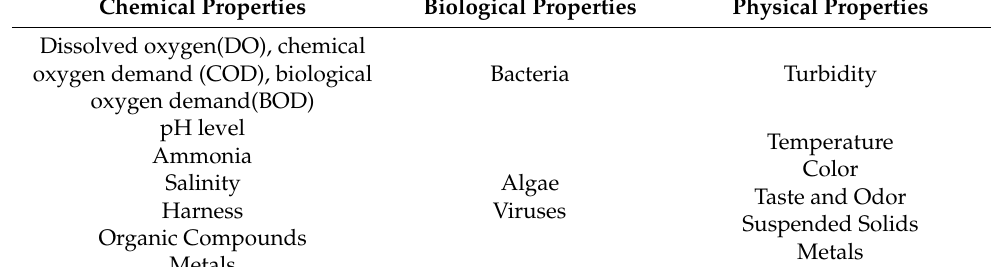
Table 1. Water Quality Properties.